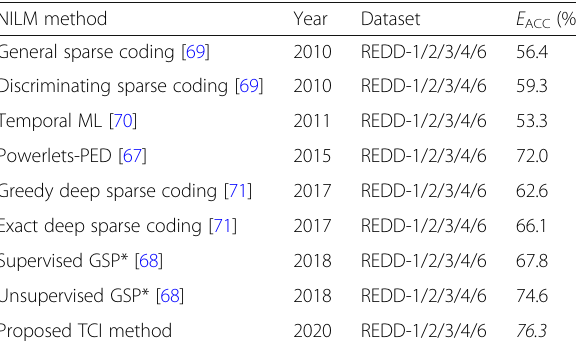
Table 6 Comparison of power disaggregation accuracy values ( E ACC ) for recently proposed NILM methodologies. The reported performance is the average E ACC across houses 1, 2, 3, 4, and 6 NILM